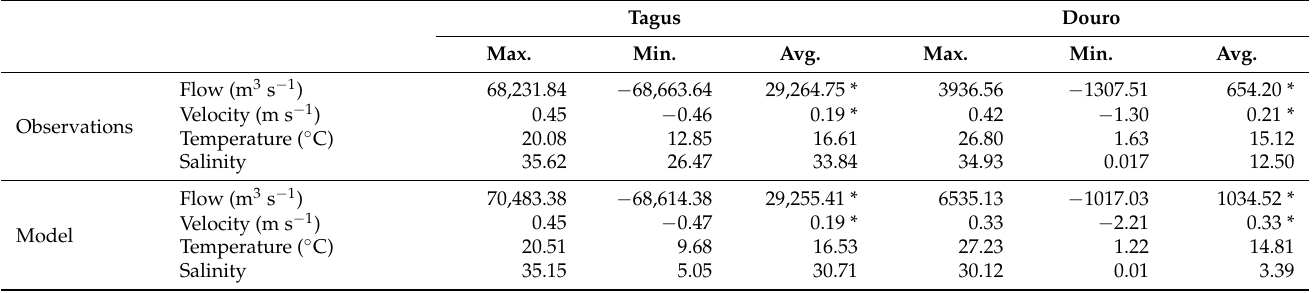
Table 2. Basic statistics for the outputs from the Tagus and Douro proxies when forced with observed flows (Obs.) and when forced with watershed models (Model). * Values were calculated with the absolute values.